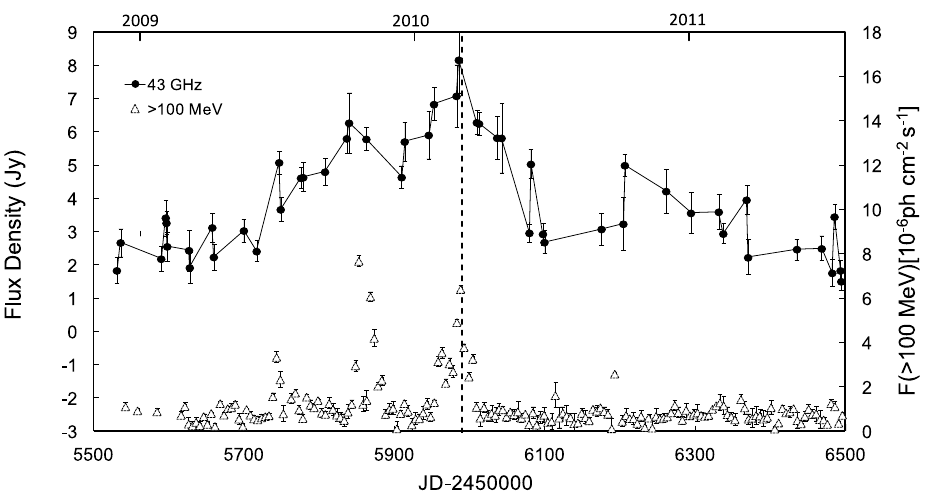
Figure 2. The radio and γ -ray variability between 2009 and 2013. The radio data was shifted by 54 days to coincide the maximum of its light curve with the last γ -ray flare, as indicated by the dashed